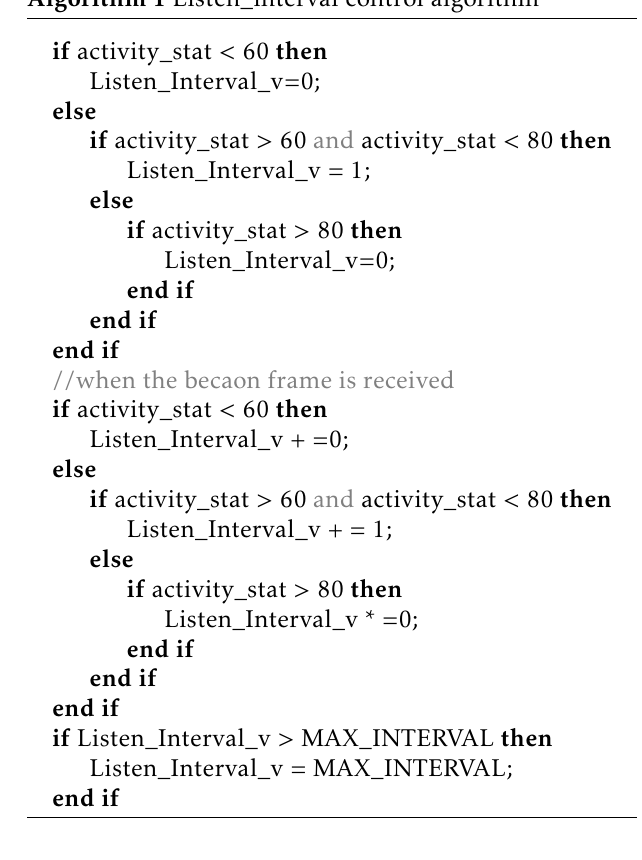
Fig. 8. The implementation of delay transmission using Listen Interval